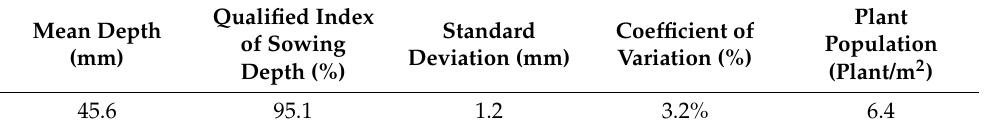
Table 9. Result of seeding depth.